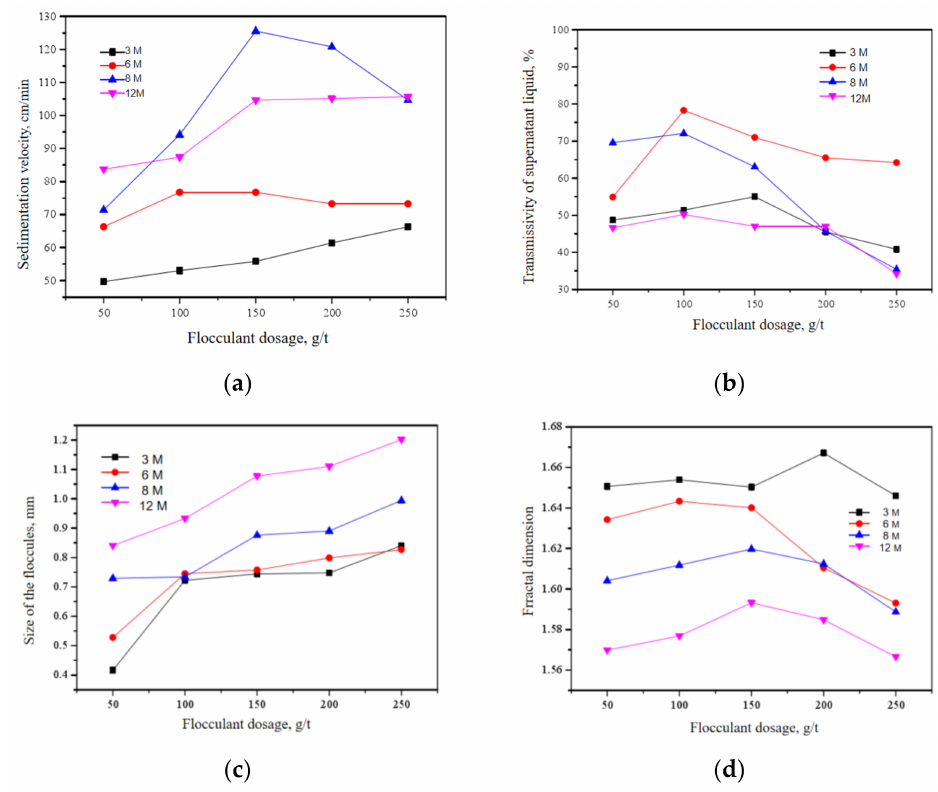
Figure 12. Testing results for different molecule mass with respect to flocculant dosage ( a ) Sedimen- tation velocity; ( b ) transmissivity of supernatant liquid; ( c ) size of the floccules; ( d ) fractal